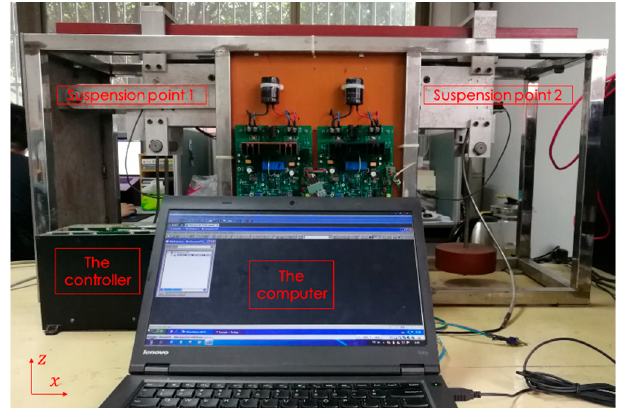
Figure 14. The small-scale experimental platform of the suspension system. Table 2. Relevant parameters of the suspension system. Symbols The Small-Scale